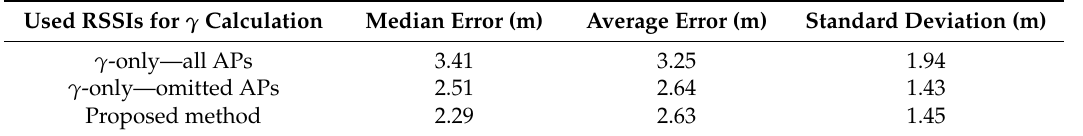
Table 2. Comparison of the mean and median errors made by all three discussed methods.